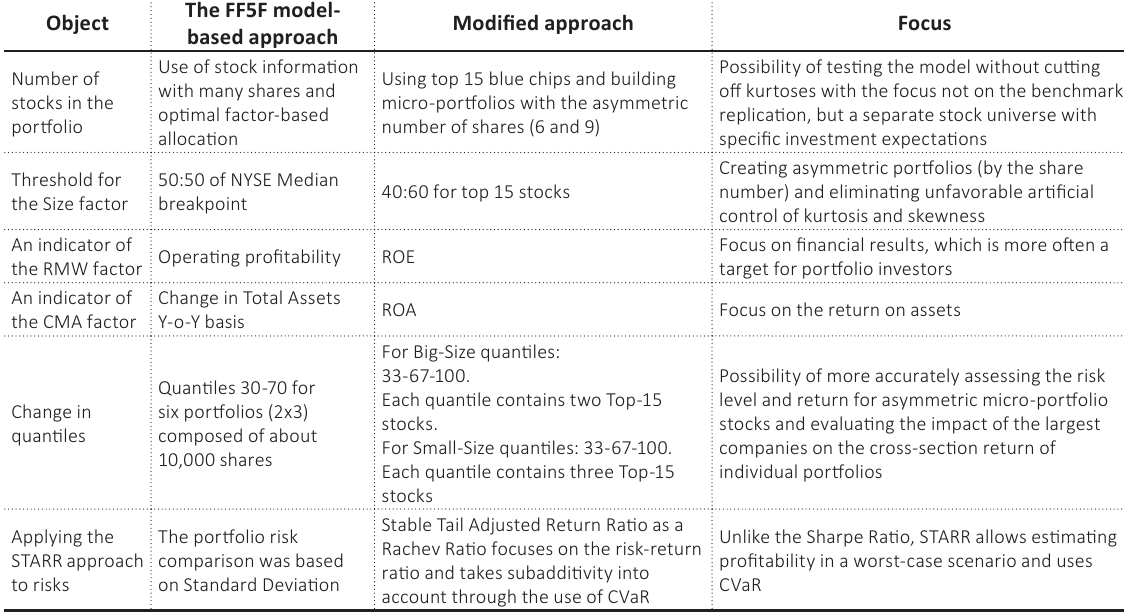
Source: Developed by the authors.